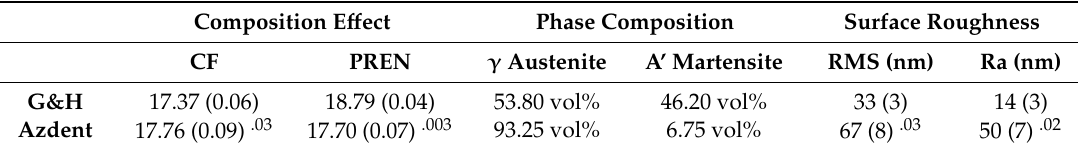
Table 2. The PGAA derived composition factor (CF) and pitting resistance equivalent number (PREN) with standard deviation (SD), phase composition and surface roughness parameters (SD) for the G&H and Azdent stainless steel archwire samples.